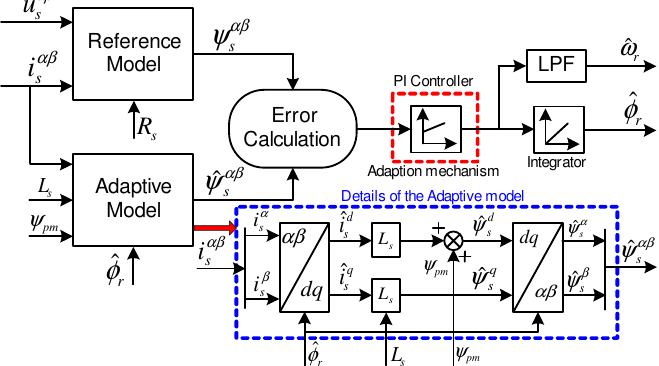
Figure 2. Structure of the traditional model reference adaptive system (MRAS) observer for SMPMSGs.